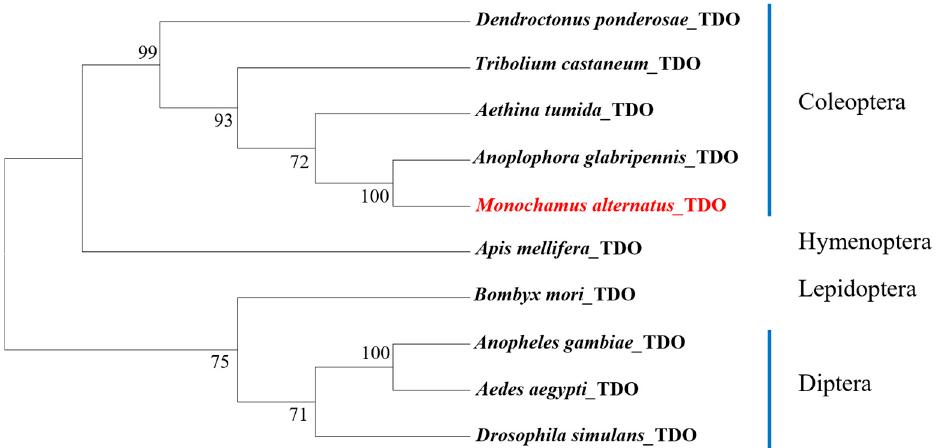
Figure 1. Phylogenetic analysis of tryptophan 2,3-dioxygenase (TDO) derived from chromosome 5 of Monochamus alternatus . Other TDO proteins are from four different coleopteran species, Dendroctonus ponderosae (XP_019756918.1), Tribolium castaneum (NP_001034499.1), Aethina tumida (XP_019868462.1), and Anoplophora glabripennis (XP_018573815.1); a hymenopteran, Apis mellifera (XP_006569049.1); a lepidopteran, Bombyx mori (XP_004922659.1); and three dipterans, Anopheles gambiae (AAC27663.1), Aedes aegypti (XP_001656460.1), and Drosophila simulans (AAA81532.1). We constructed the tree using the neighbor-joining method based on full-length protein sequence alignments. Bootstrap analyses of 1000 replications were performed, and bootstrap values > 50% are shown on the tree. TDO is located on chromosome 5 of M. alternatus (Ma TDO ). Only one domain of